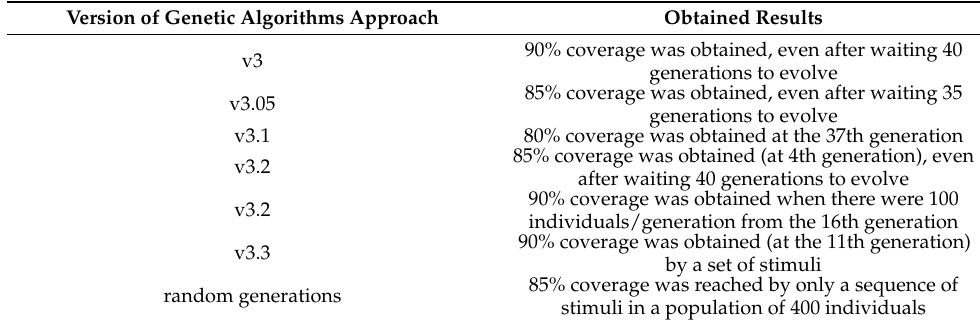
Table 4. Results for ALU when values of result were split in 20